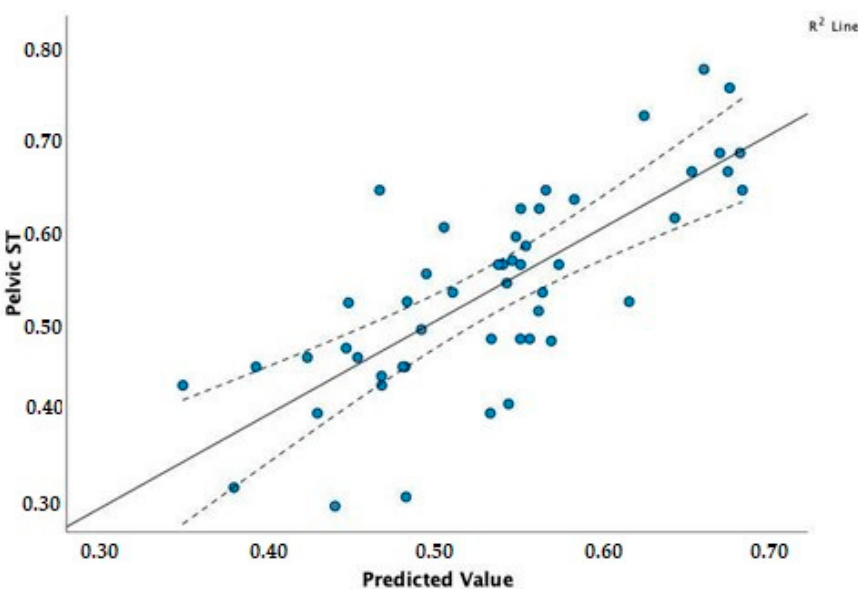
Figure 6. Correlation scatterplot of pelvic ST for the observed values and those predicted by the